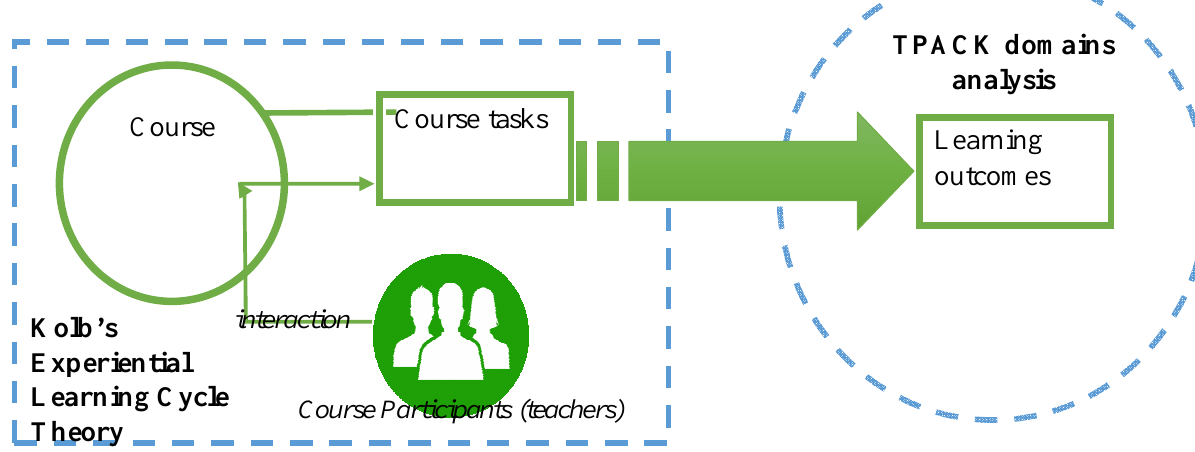
Figure 1: Conceptual